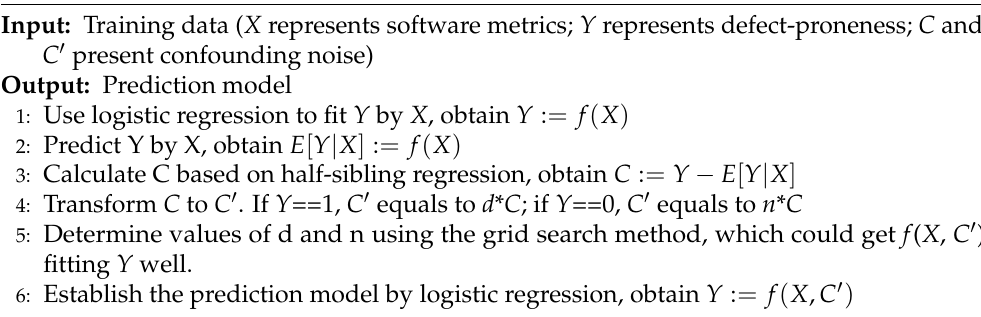
Algorithm 1 Predictive model.